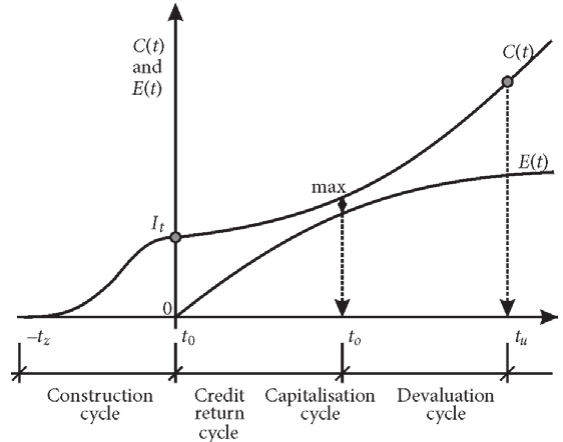
Fig. 3. Life Cycle Costs – bad proposal